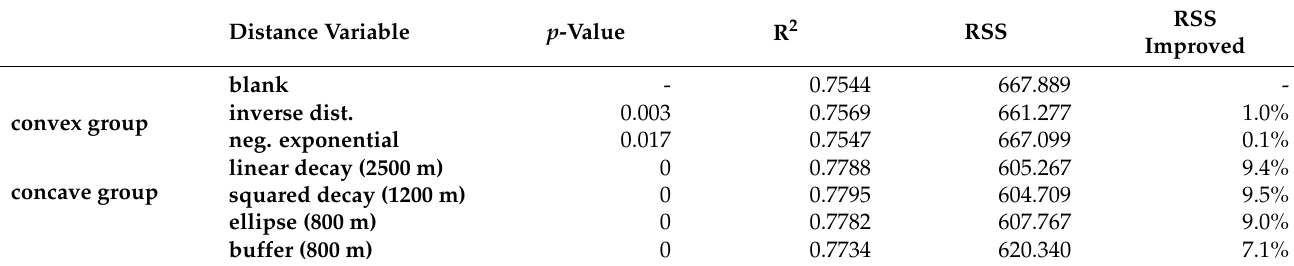
Table 6. RSS comparison of functions for MRT accessibility